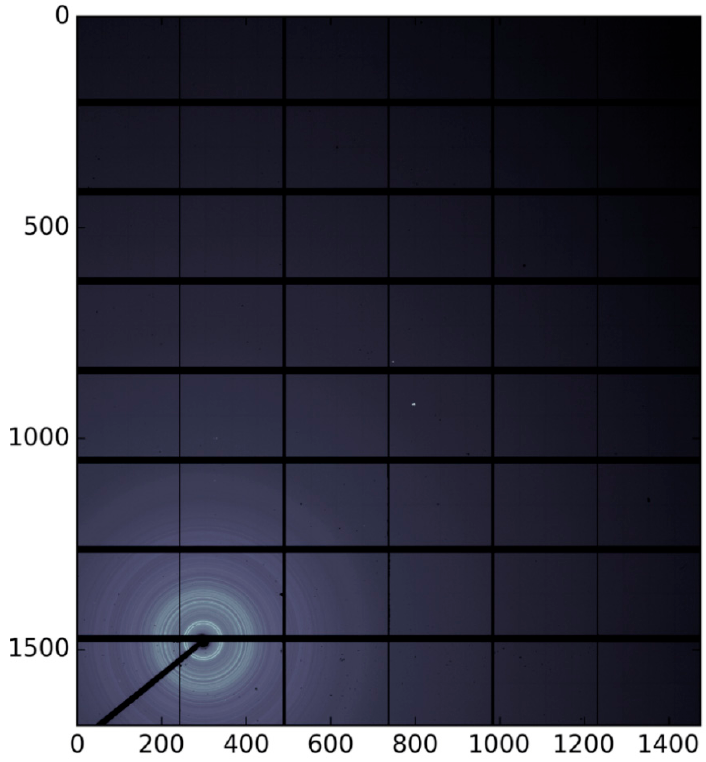
Figure A3. Raw two-dimensional images of PEDOT_Naph.